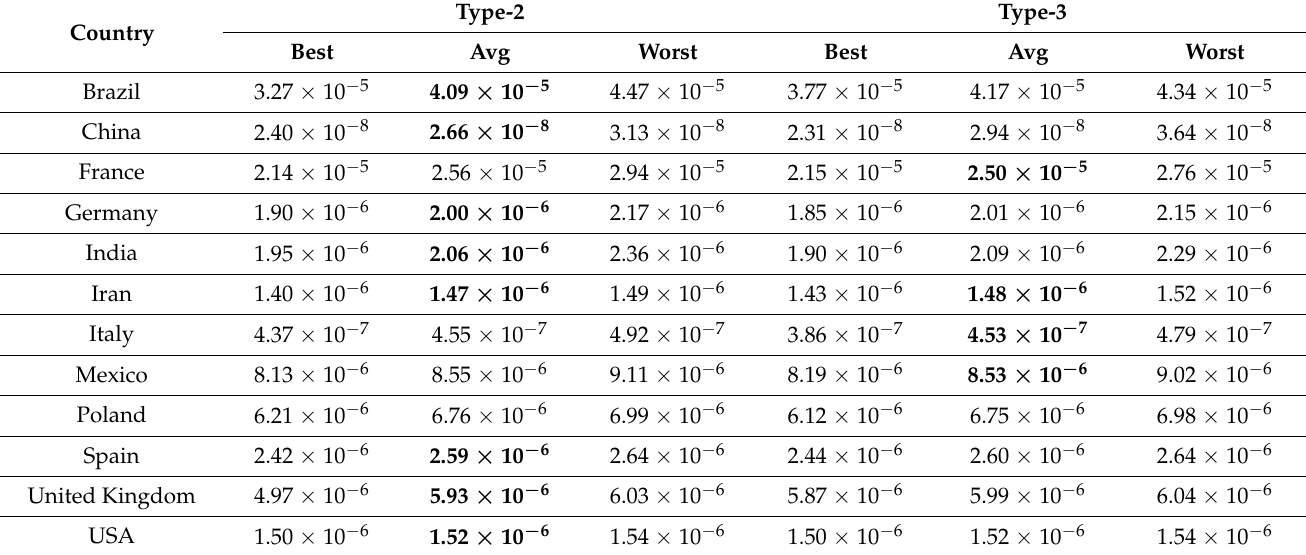
Table 14. Second data period (testing prediction).